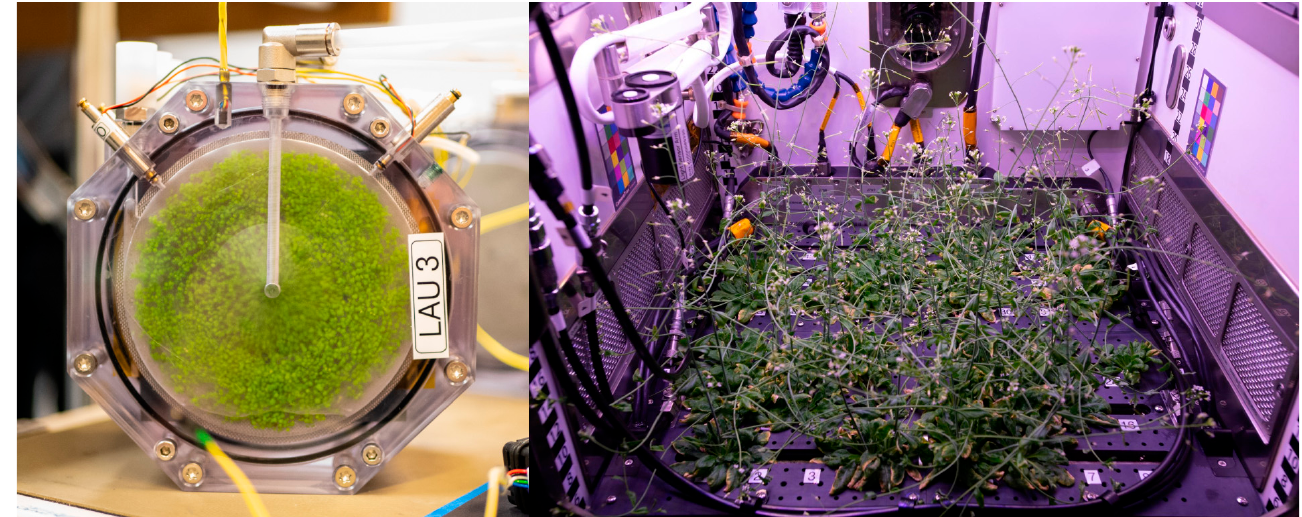
Figure 6. The model organism Arabidopsis thaliana is used in various microgravity research applications. ( Left ): 5-day-old seedlings in a fixation chamber moments before integration into a sounding rocket during the TEXUS 57 campaign (hardware designed by Airbus Defence and Space). ( Right ): Flowering Arabidopsis plants inside the Plant Habitat-01 in the European Columbus laboratory module aboard the ISS (image courtesy of NASA).